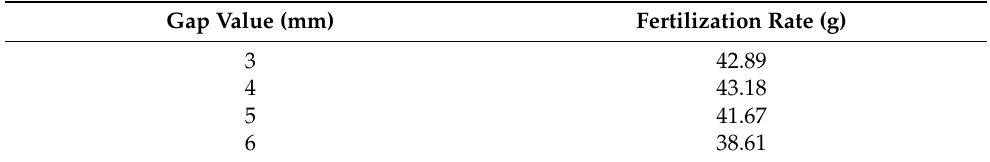
Table 6. Fertilization performance under different gaps between the spiral blades and the discharge cavity. Gap Value (mm)